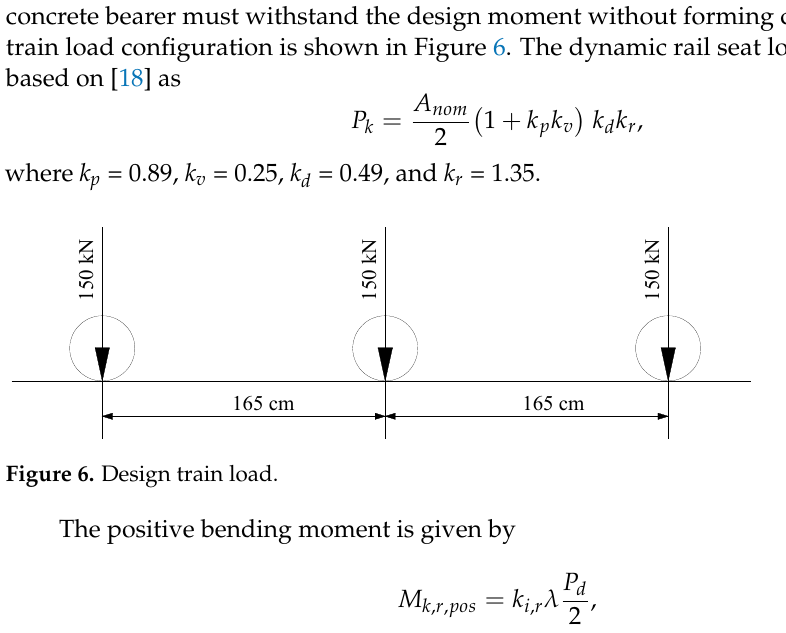
Figure 6. Design train load. The positive bending moment is given by 𝑀 (cid:3038),(cid:3045),(cid:3043)(cid:3042)(cid:3046) = 𝑘 (cid:3036),(cid:3045) 𝜆 (cid:3017) (cid:3279) (cid:2870) ,